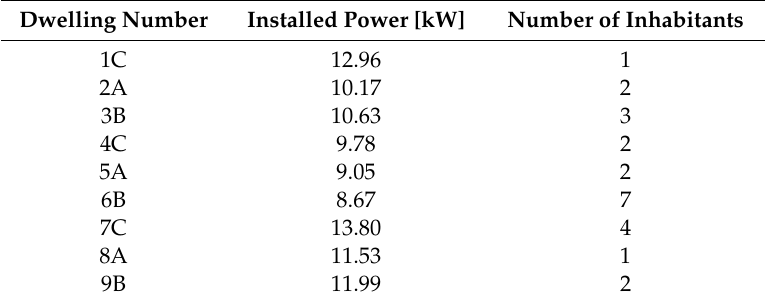
Table 2. Installed heating power and number of inhabitants of each dwelling. Dwelling Number Installed Power